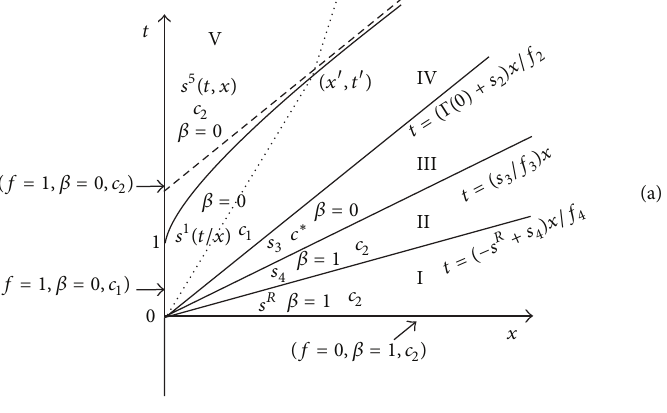
Figure 9: Non-self-similar solution of the problem for wave inter- actions in (𝑥,𝑡) -plane.